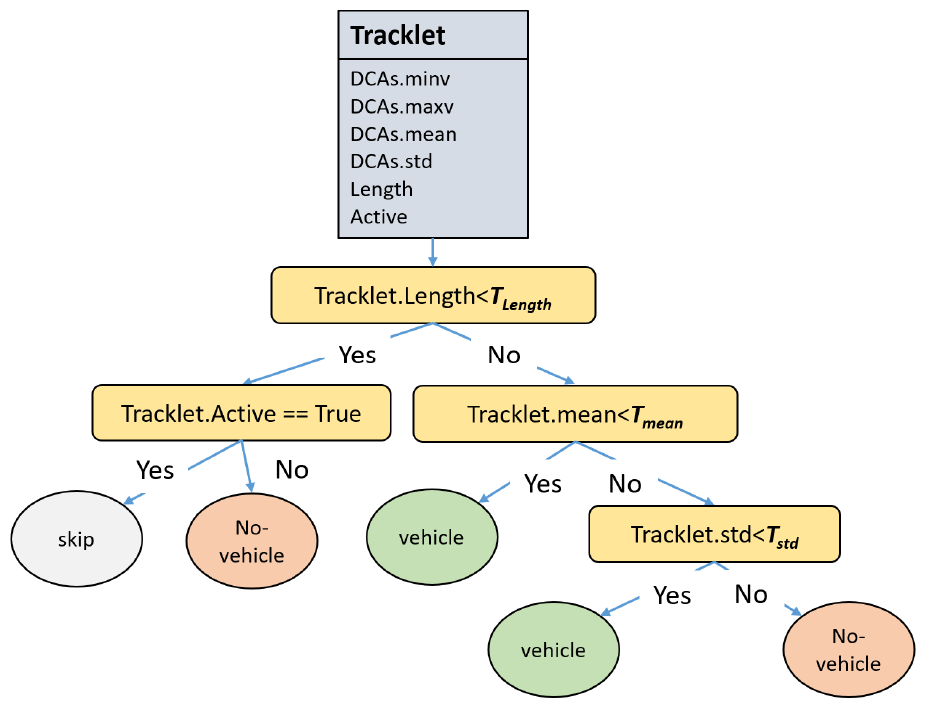
Figure 6. Decision tree of classification based on the attributes of the tracklet.